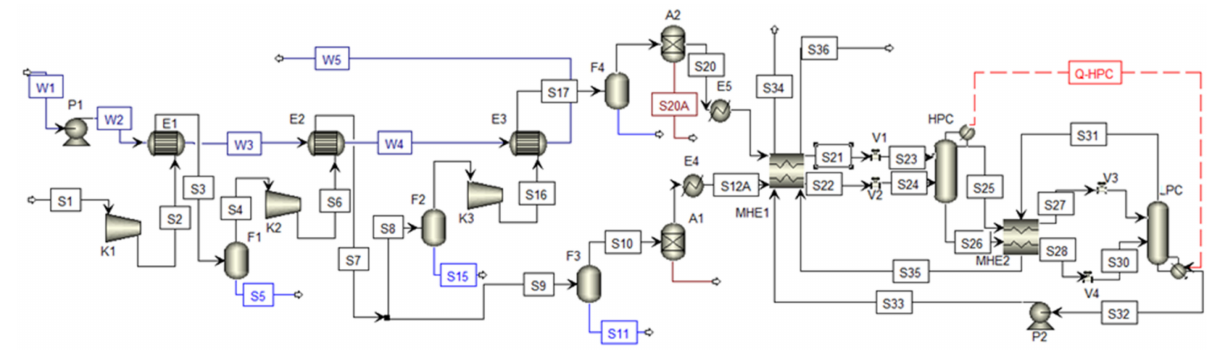
Figure A1. Modified process flow scheme. A: adsorber; E: heat exchanger; F: phase separator; HPC: high-pressure column; K: compressor; LPC: low-pressure column; MHE: multi-stream heat exchanger; Q: heat flow; P: pump; S: material stream; SS1: stream splitter; V: valve; W: cooling water stream.